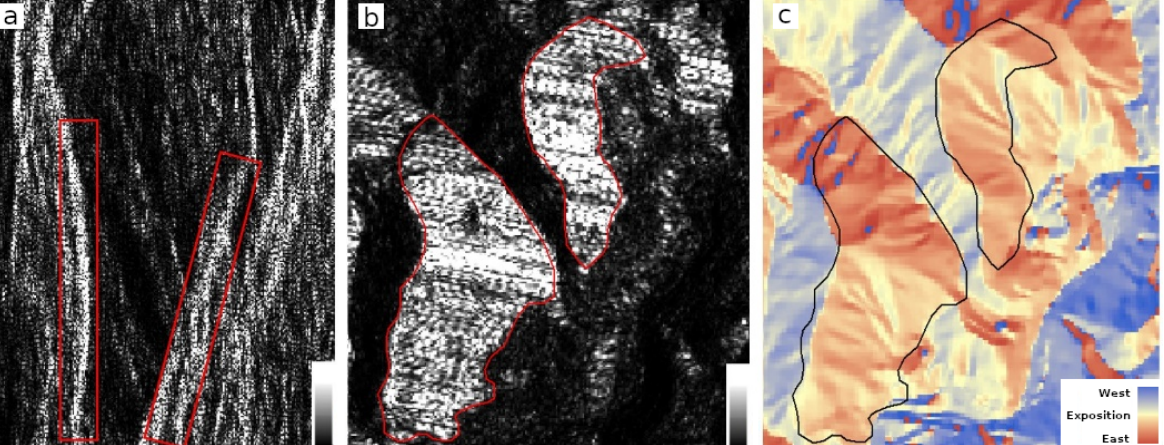
Figure 3. SAR intensity images in slant-range ( a ) and in ground-range ( b ). The associated topographic aspect map is shown in ( c ). Two marked areas indicate identical slopes (red polygons in ( a , b ), black polygons in ( c )). Based on the pattern shown on east-facing slopes in ( b ), it is clear that the foreshortening effect is not fully addressed, which may cause misjudgment in the following change